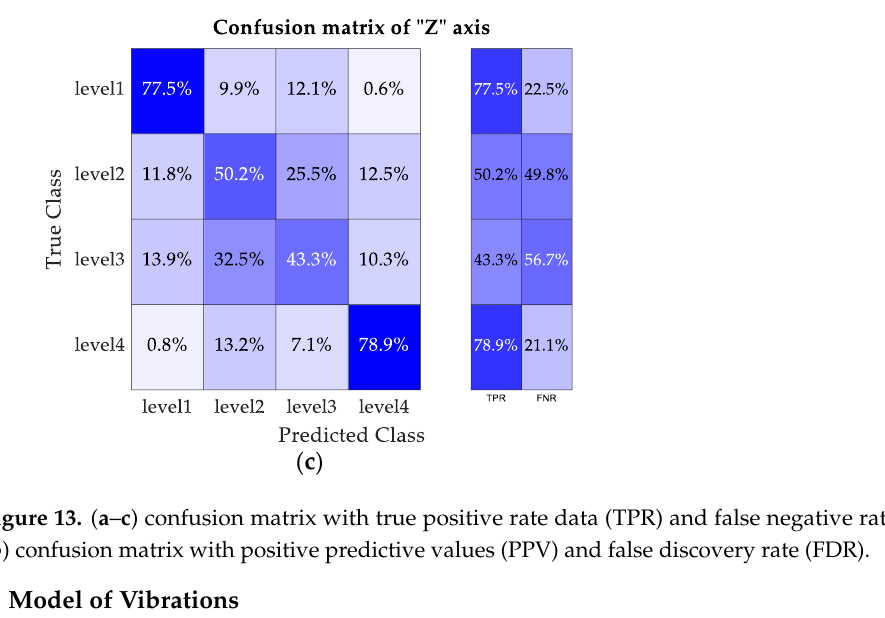
Figure 13. ( a ), ( b ), ( c ) confusion matrix with true positive rate data (TPR) and false negative rate (FNR) b) confusion matrix with positive predictive values (PPV) and false discovery rate (FDR).